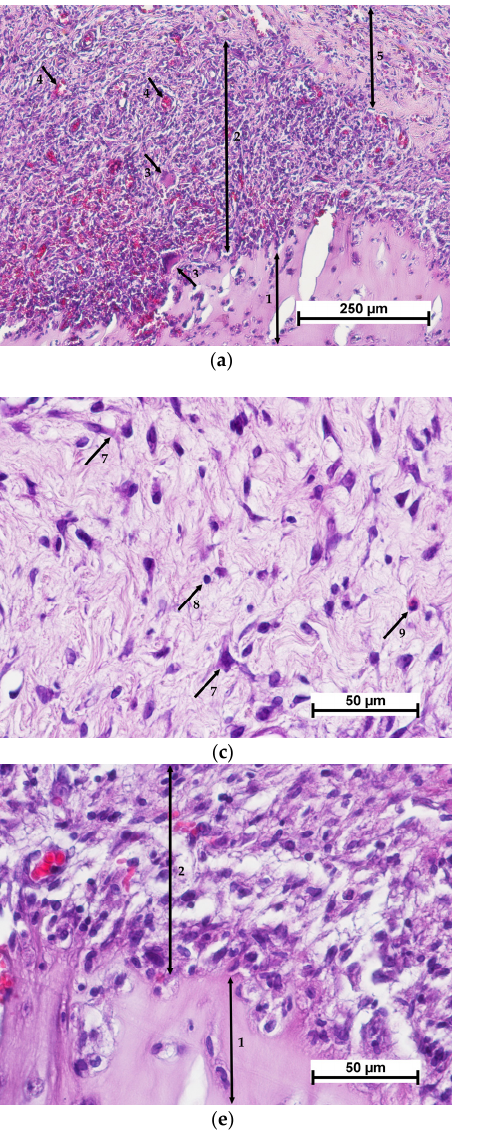
Figure 7. Histological picture—day 7. Comparison of cell-containing scaffold ( a , c , e ) and cell- containing collagen matrix ( b , d , f ). ( a , b )—implant with surrounding tissue, general view, ( c , d )— connective tissue structure surrounding the implant, ( e )—cell-containing scaffold surrounded by resorbing cells, ( f )—collagen matrix structure. Staining with hematoxylin–eosin. Note: (1)—scaffold; (2)—layer of resorbing cells (macrophages); (3)—giant multinucleated cells; (4)—blood vessels; (5)— connective tissue structure around the implant; (6)—collagen matrix; (7)—fibroblast; (8)— lymphocyte; (9)—granulocyte; (10)—macrophage.